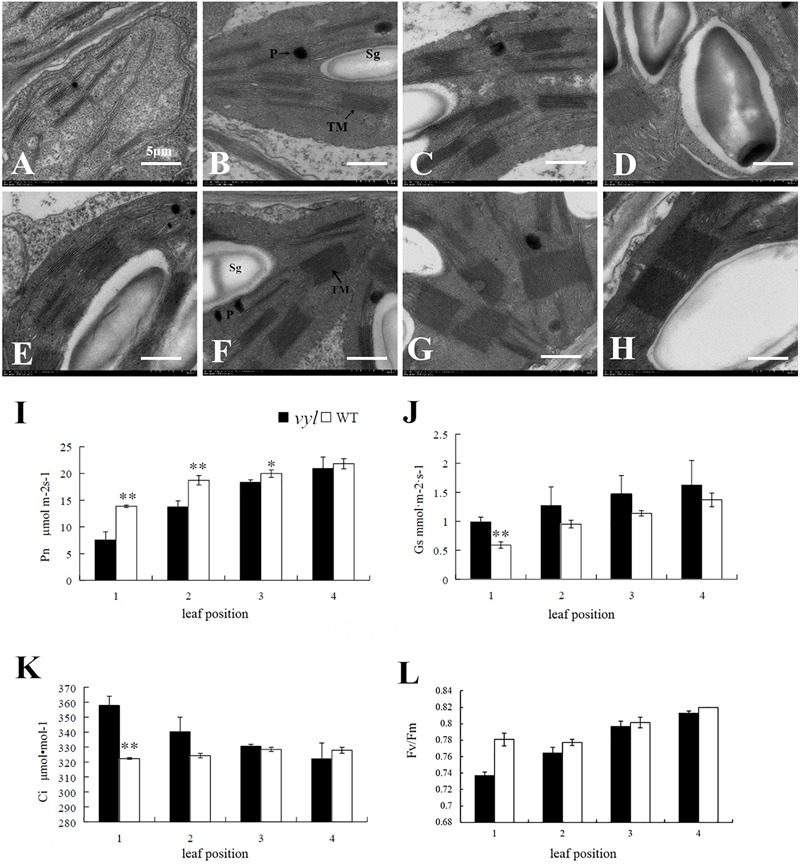
Chloroplast structure and photosynthesis parameters of vyl and WT at different leaf position. Electron microscopy of chloroplasts ultrastructures in L1-L4 of vyl
(A–D) and WT (E–H). TM, thylakoid membrane; Sg, starch grain; P, plastoglobulus. Scale bar = 500 nm. (I) Net photosynthetic rate (Pn); (J) Stomatal conductance (Gs); (K) Intercellular CO2 concentration (Ci); (L) Photosystem II (Fv/Fm); Values are the mean ± SD, and ∗(P < 0.05) and ∗∗(P < 0.01) indicate significant difference between the treatments.